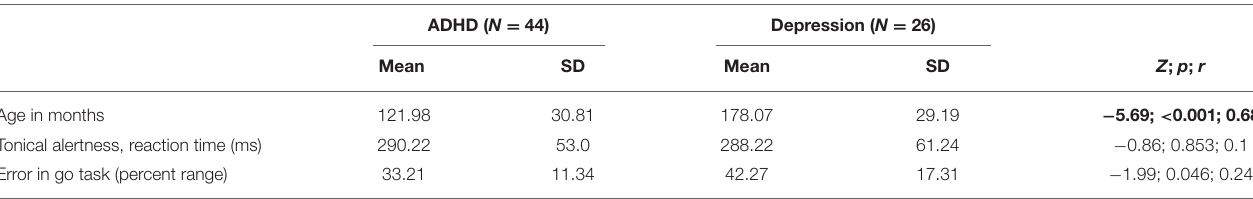
TABLE 3 | Attentional task performance.